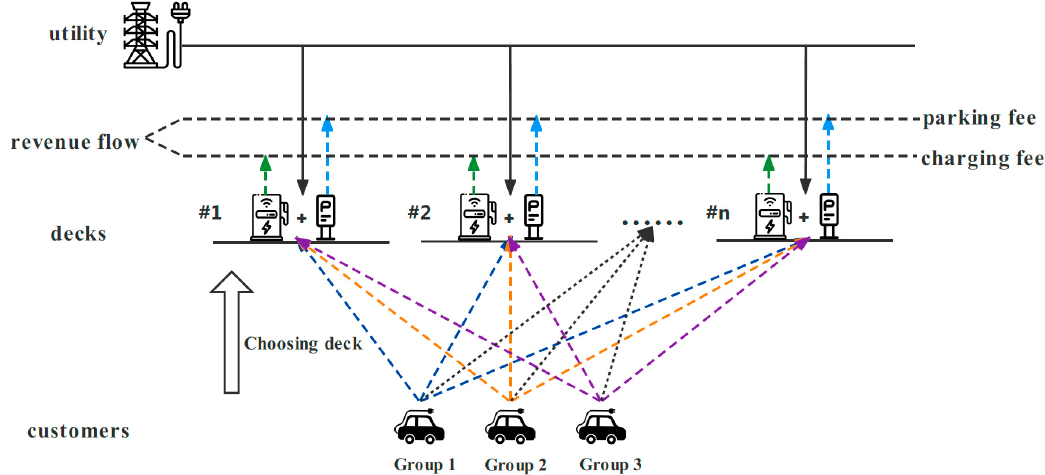
Figure 1. The envisioned system architecture of multiple EV charging/parking facilities.